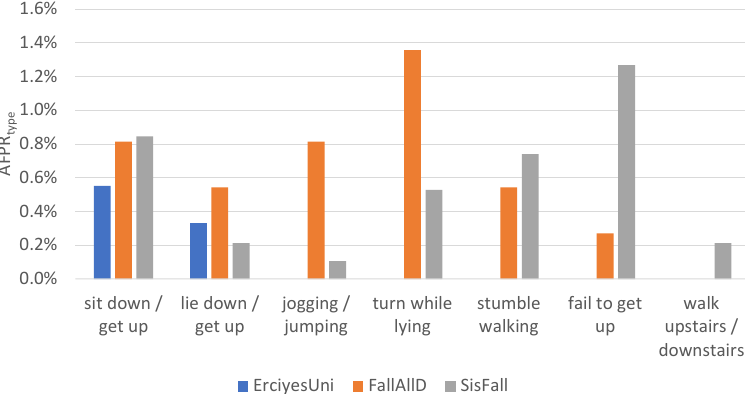
Figure 8. Percentage of all ADL misclassified as fall, grouped by ADL types ( AFPR type ).